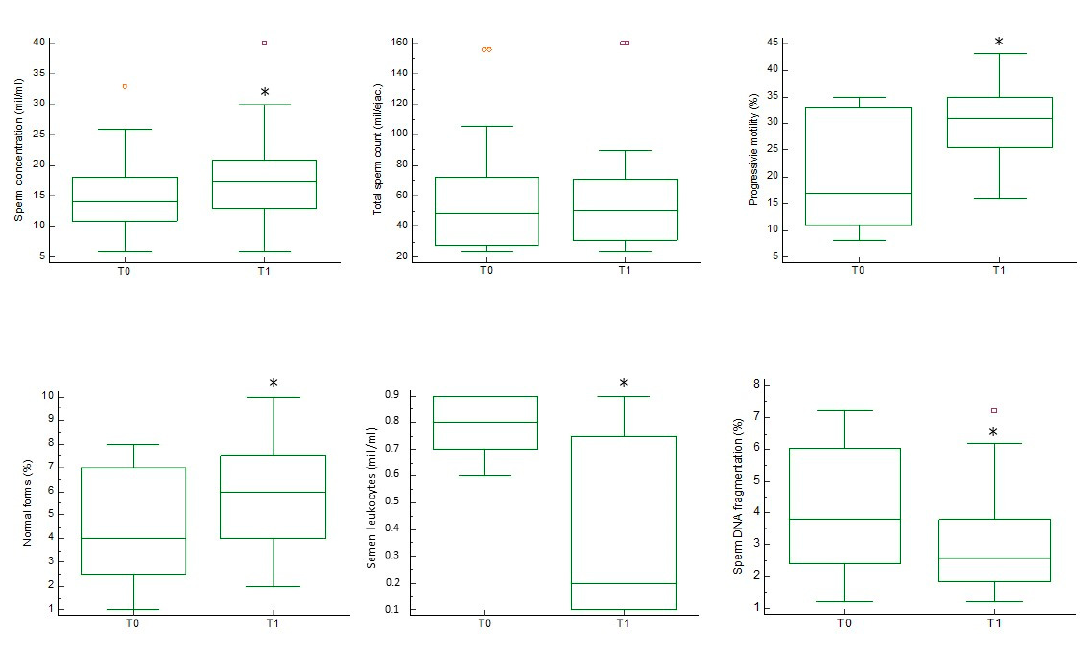
Figure 1. Conventional sperm parameters before and after selenium administration. Sperm concentration, total sperm count, progressive motility, morphology, leukocytes, and sperm DNA fragmentation are shown before (T0) and after (T1)